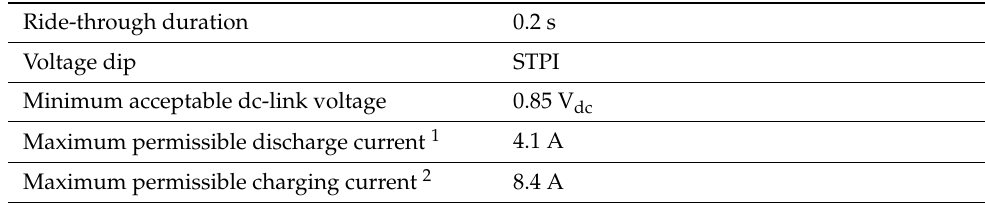
Table 1. Ride-through